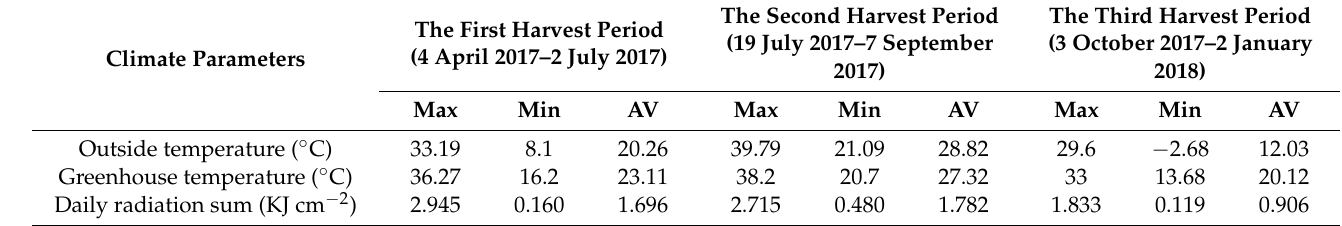
Figure 2. Changes in greenhouse temperature, daily radiation sum and outside temperature in 2017. Data for greenhouse temperature and outside temperature were recorded every half an hour. Table 2. The maximum, minimum and average outside temperature, greenhouse temperature and radiation sum for different harvest periods. Max, Min, AV represent the maximum, minimum, average values of the climate